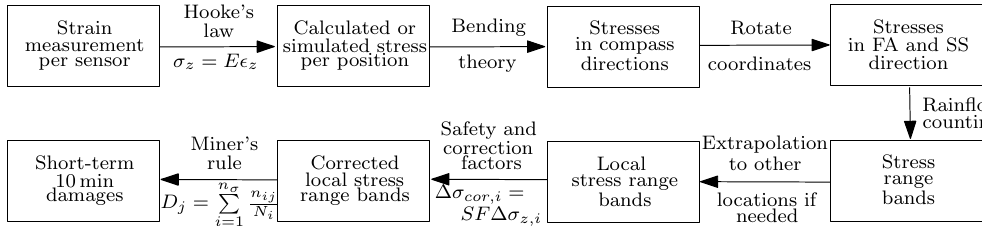
Figure 1. Flowchart presenting the short-term damage calculation procedure based on strain measurements or stress simulation (FA: fore-aft, SS: side-to-side). Explicitly stated methods such as Hooke’s law are common examples but could also be replaced by more accurate